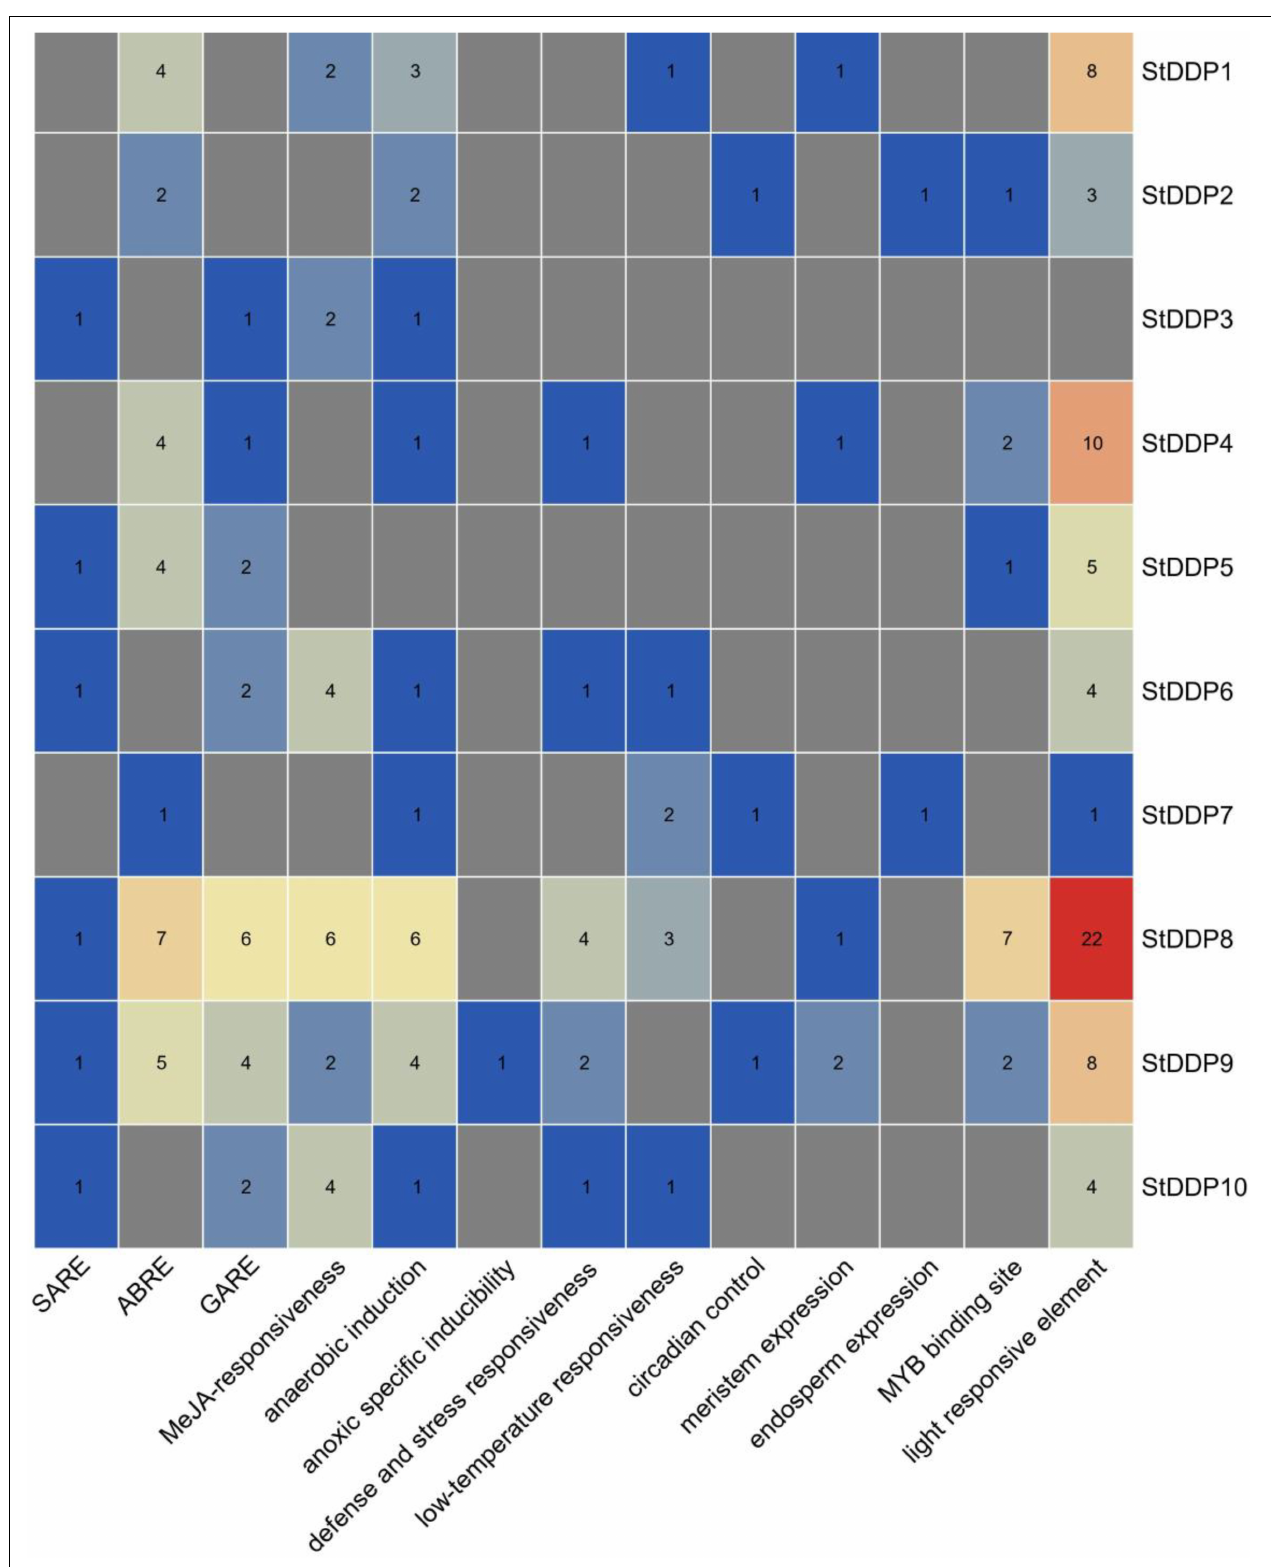
FIGURE 4 | Predicted cis -acting elements in StDDP promoters. Promoter sequences (2,000 bp) of ten StDDP genes were analyzed by PlantCARE.